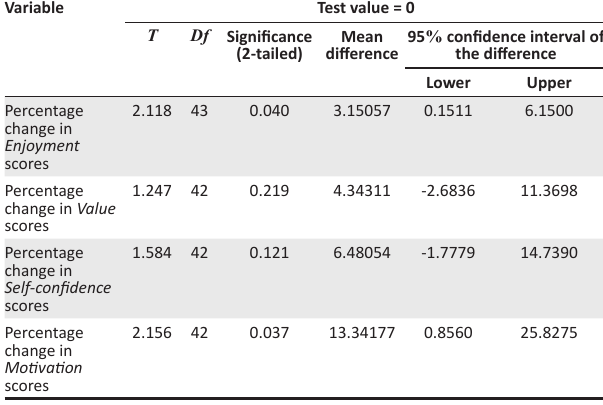
TABLE 7 : One-sample t -test for percentage changes in each